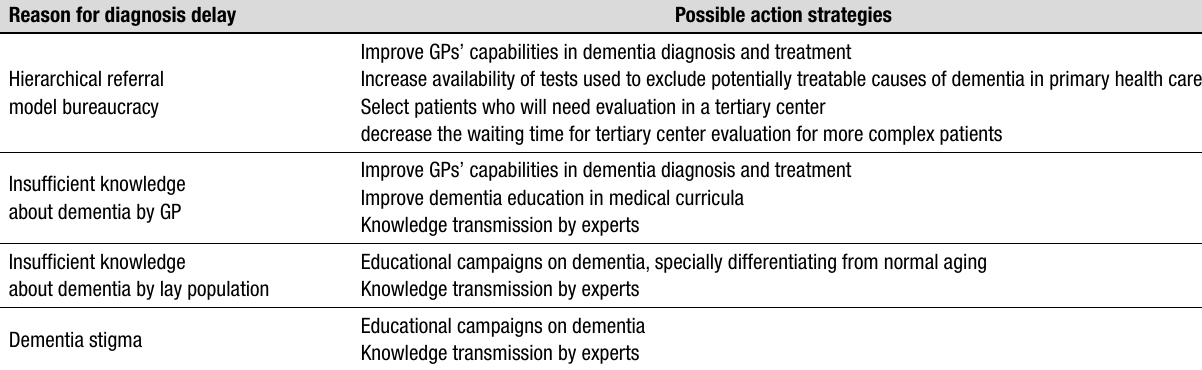
Table 3. Reasons for delayed diagnosis of dementia and suggested strategies for improvement in Brazil. Reason for diagnosis